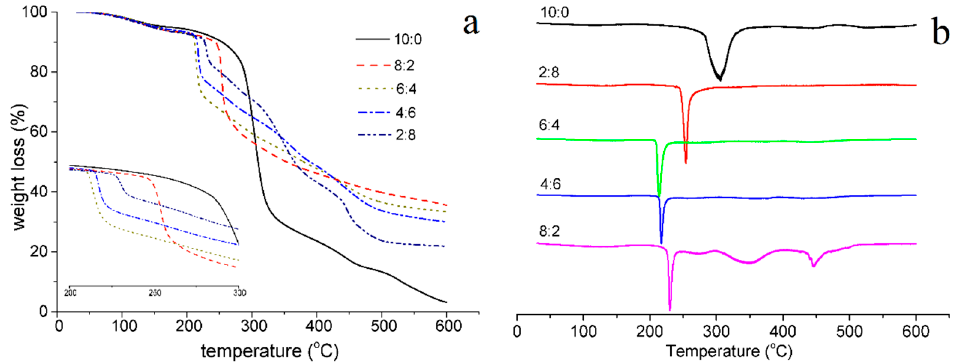
Figure 5. TGA and DTA curves of the composite films with different St/PL mass ratios. ( a ) TGA. ( b ) DTG.